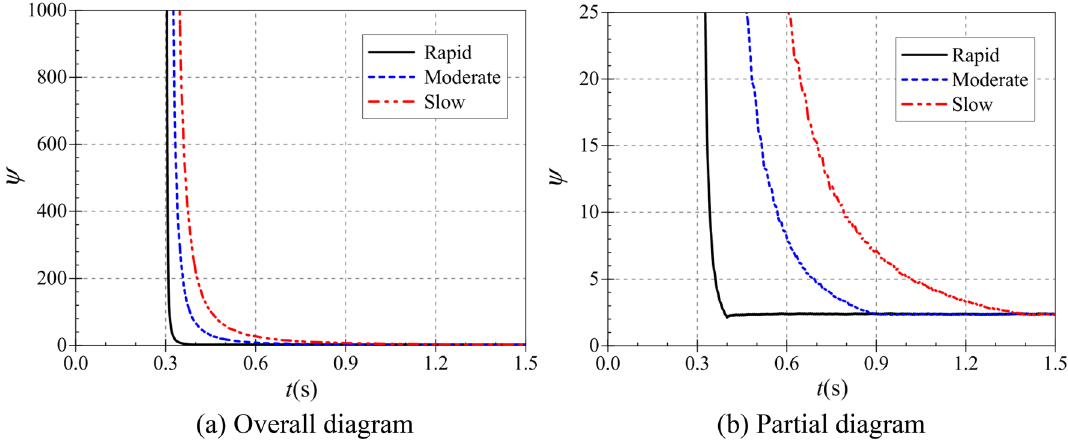
Figure 17. Dimensionless head coefficient. ( a ) Overall diagram, ( b ) Local